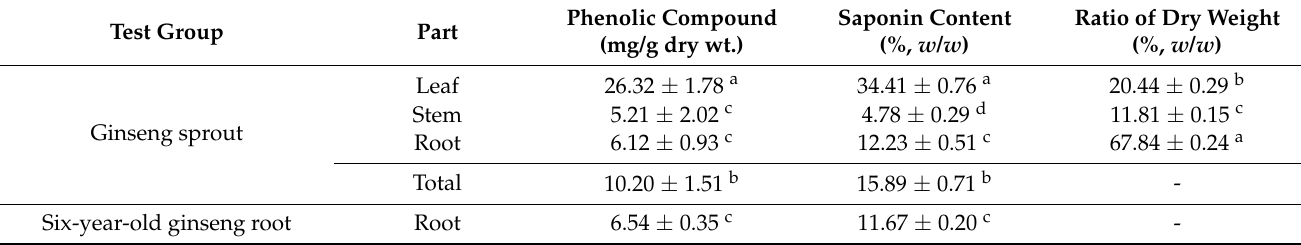
Table 1. Total phenolic compound and crude saponin content in ginseng sprout and six-year-old ginseng root. Test